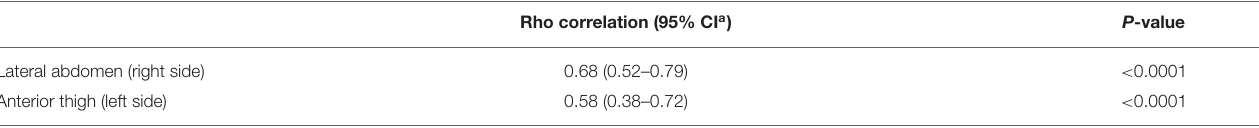
TABLE 4 | Correlation between manual and automated baseline